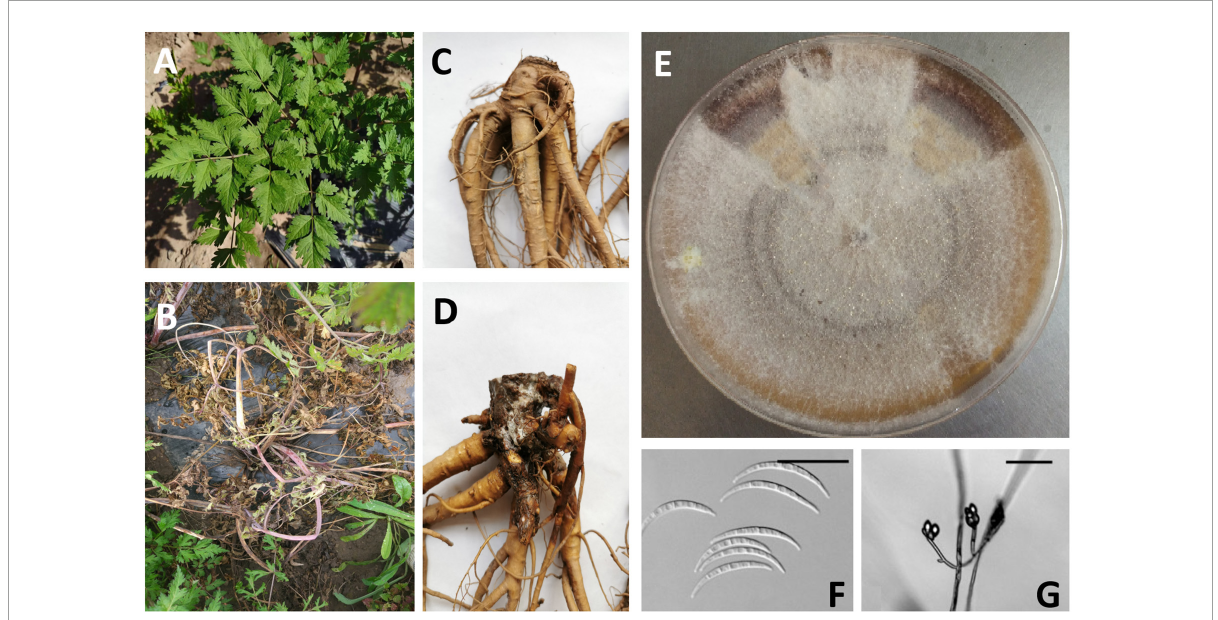
FIGURE1 Observation of root rot symptom ( Angelica sinensis ) resulting from infection of F. tricinctum , above ground ( A: healthy plant; B: infected plant) and below ground ( C: healthy root; D: infected root); Colony of F. tricinctum on a PDA plate (E) ; Micrograph image of F. tricinctum macroconidia ( F , scale bar = 25 µ m) and Microconidia ( G , scale bar = 50 µ m). (A–E) Photos taken by Dr. Liu of our group; (F,G) borrowed from Leslie and Summerell (2006).